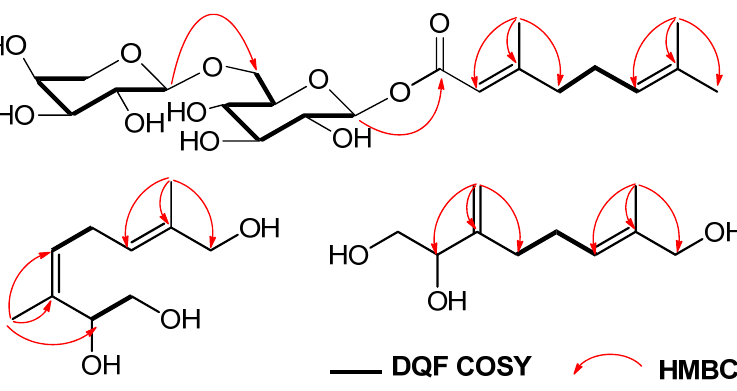
Figure 2. Key HMBC and 1 H- 1 H COSY correlations of 1 – 3